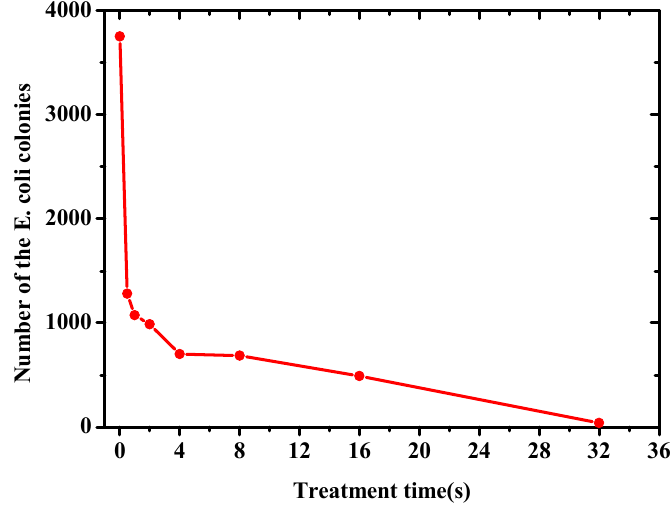
Figure 9. Numbers of the E. coli colonies with the treatment time varied.